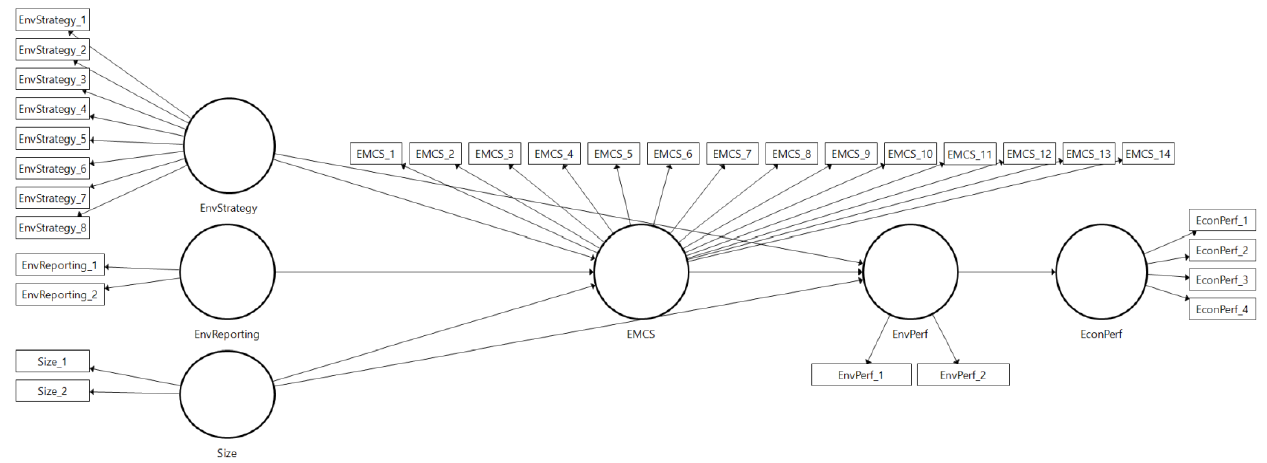
Figure 1. Model of relationships between strategy, environmental management control system, environmental performance, and economic performance.